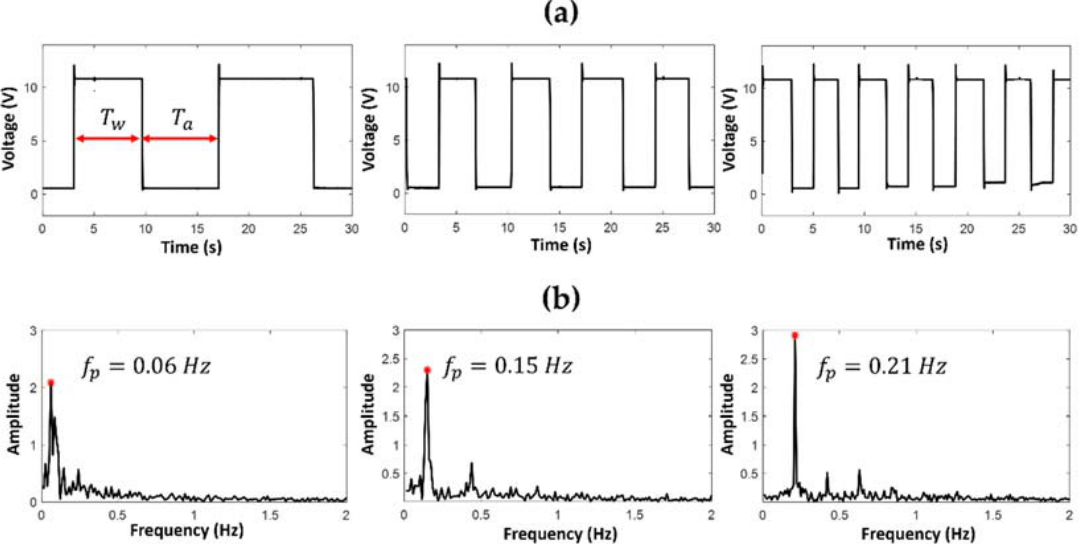
Figure 9. Optical acquisition for FLOW1 in PDMS mofd using EXP1 combinations, flow rate V air = V water = (0.1, 0.2, 0.3) mL/min: ( a ) the slug passage signals, and ( b ) the spectra.